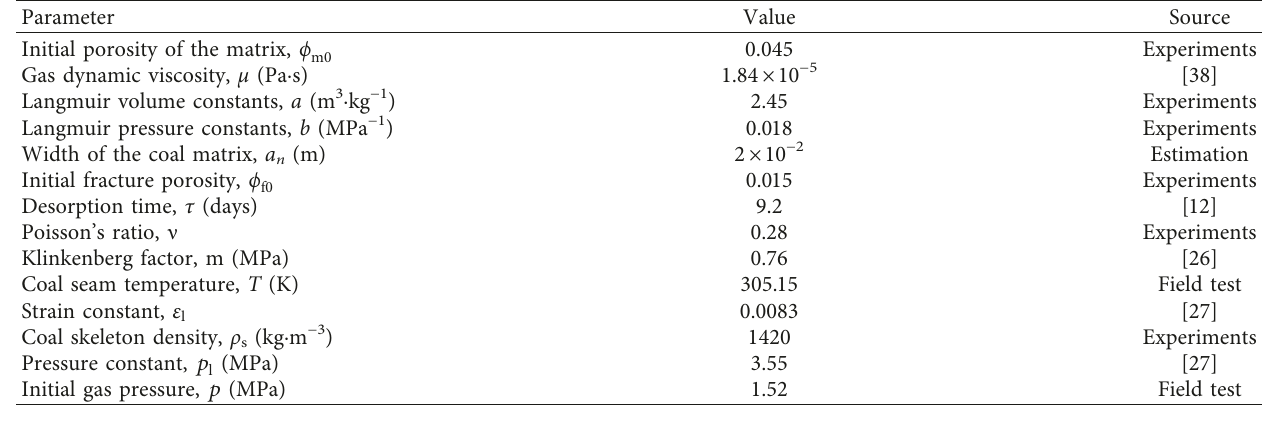
Table 1: Related parameters for simulation of underground gas extraction.